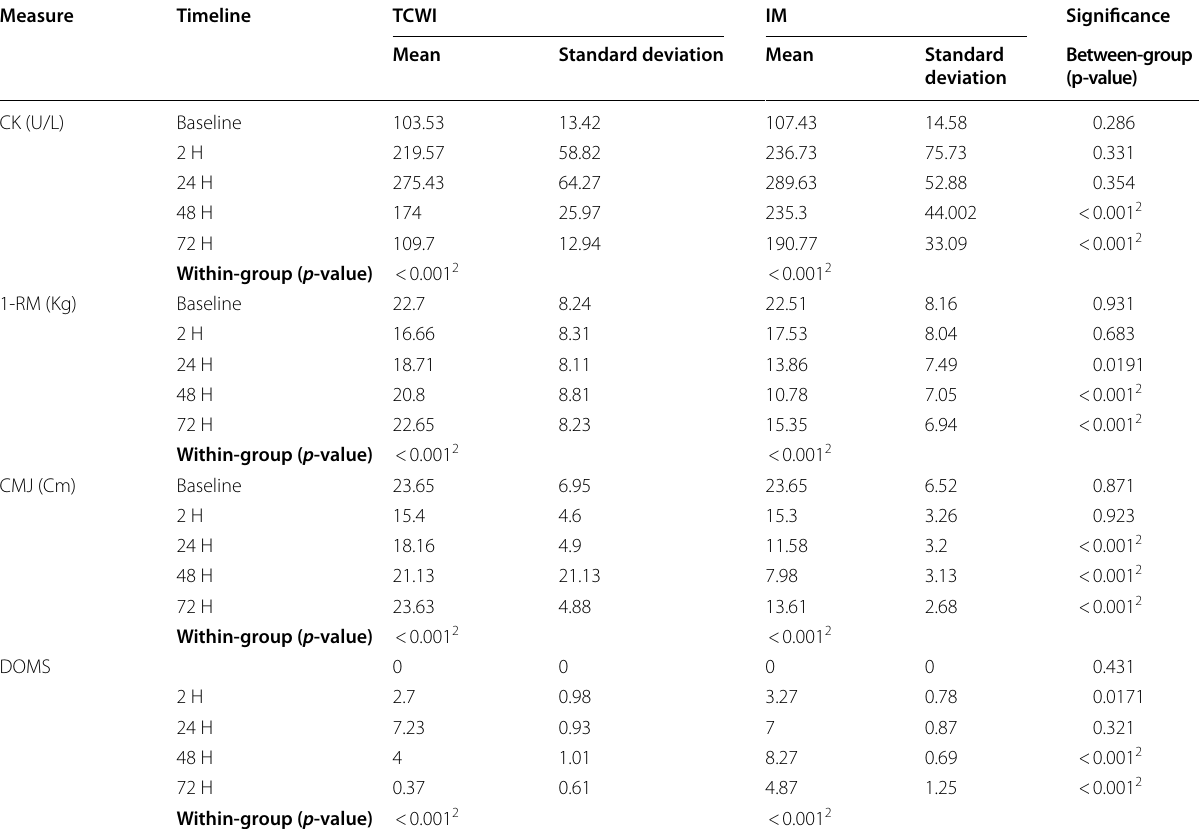
Table 1 Computation of within and between groups statistical significance of dependent variables at different